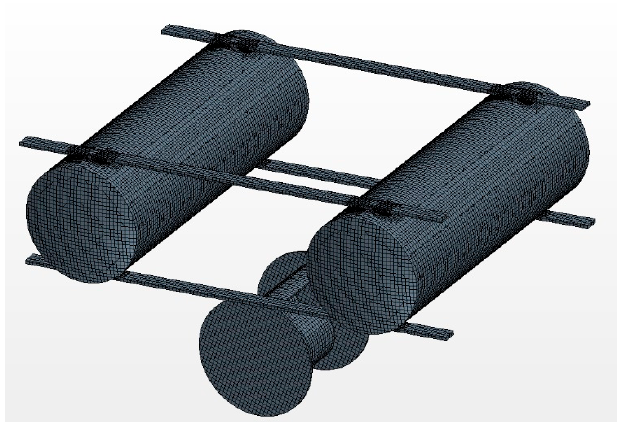
Figure 5. Grid division diagram.